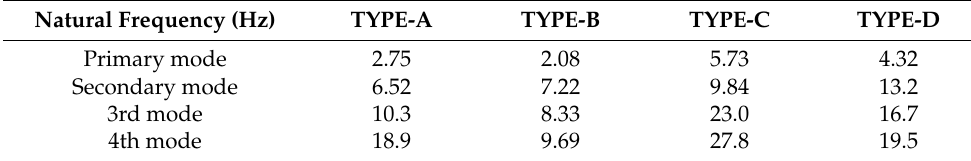
Table 2. Results of eigenvalue analysis.